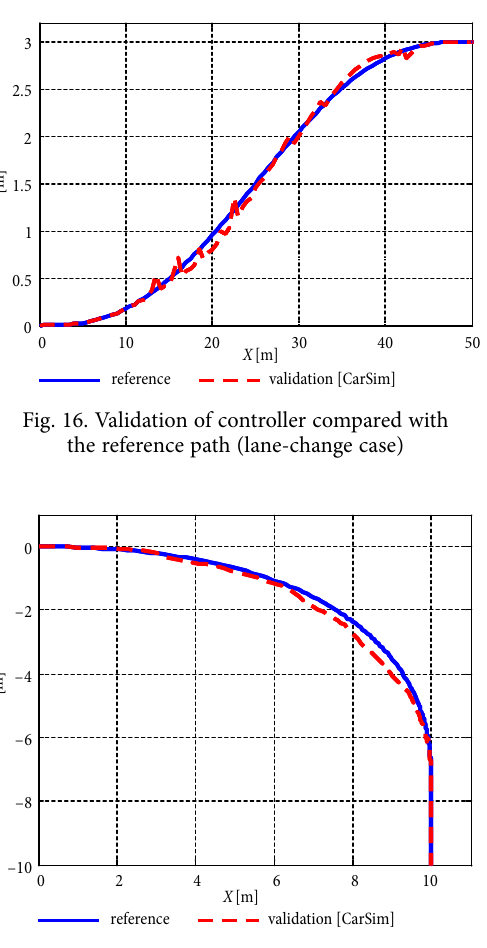
Fig. 17. Validation of controller compared with the reference path (right-angle turn case) Table. Main parameters of vehicle model in